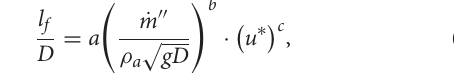
speed, the leading edge also starts to briefly extinguish and